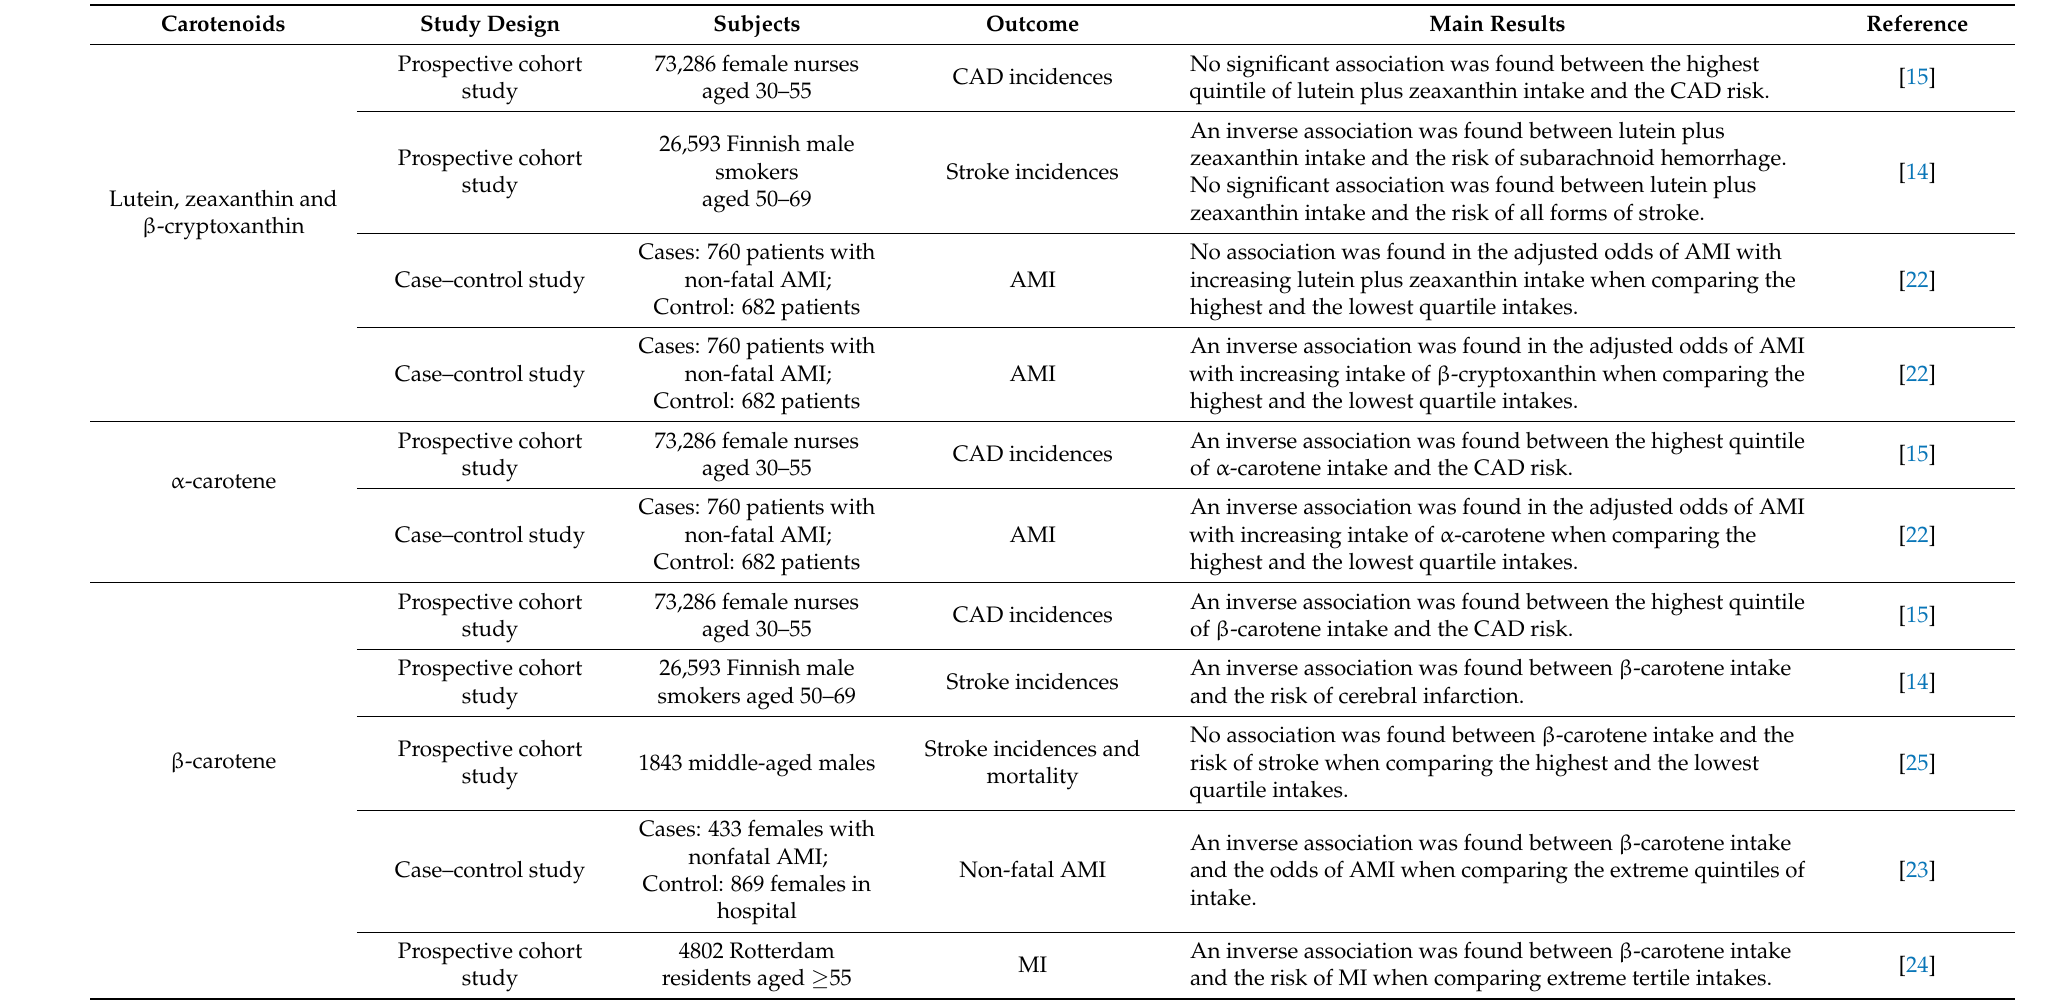
Table 1. Association between the dietary intake of carotenoids and the risk of CVDs from observational